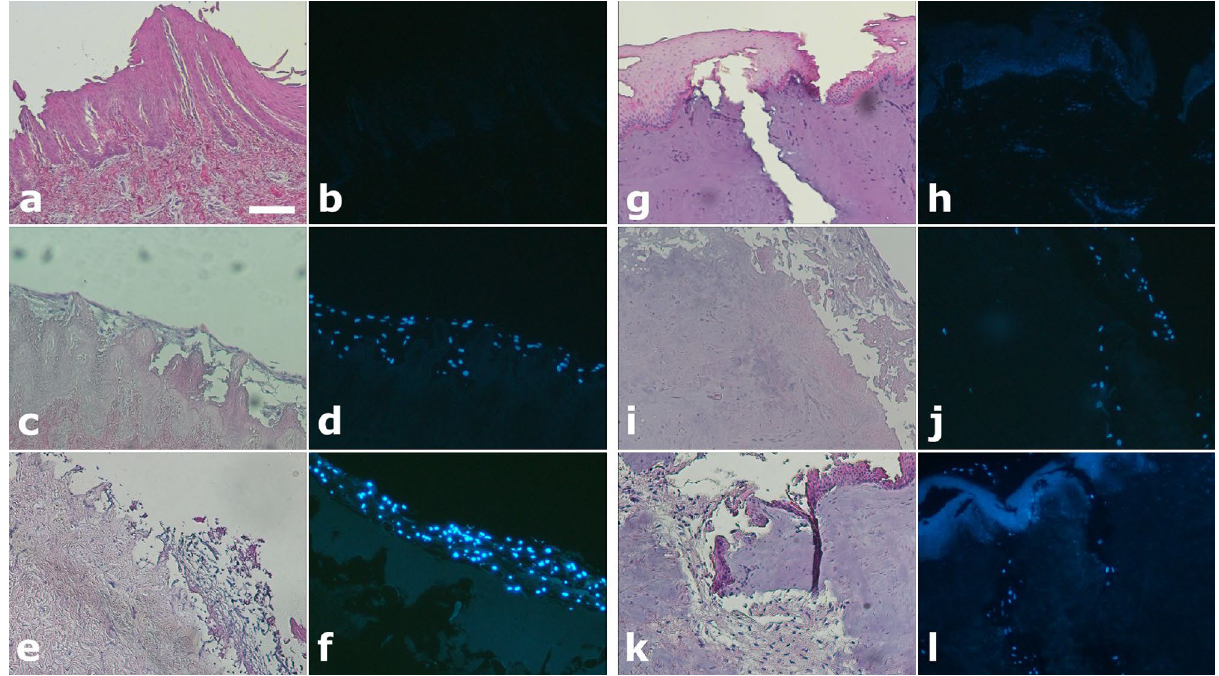
Figure 5. ( a – l ) Light and fluorescence microscopy images of non-pored ( a – f ) and pored ( g – l ) scaffolds stained either with HE ( a , c , e , g,i , k ) or DAPI ( b , d , f , h , j , l ), before and after seeding with MSCs cultured with FBS. ( a , b , g , h ) Pre-seeding images of both non-pored ( a , b ) and pored ( g , h ) scaffolds reveal no presence of MSCs. ( c , d , i , j ) After 7 days post-seeding, MSCs have adhered superficially to the non-pored scaffold ( c , d ) while in the pored one ( i , j ) a repopulation of the channels was already observed. ( e , f , j , k ) After 14 days post-seeding, MSCs were even more present on the surface of the non-pored scaffold ( e , f ), while they were able to penetrate deeper and with a great extent in the pored one ( k , l ). All the figures in the panel are the same scale; bar—100